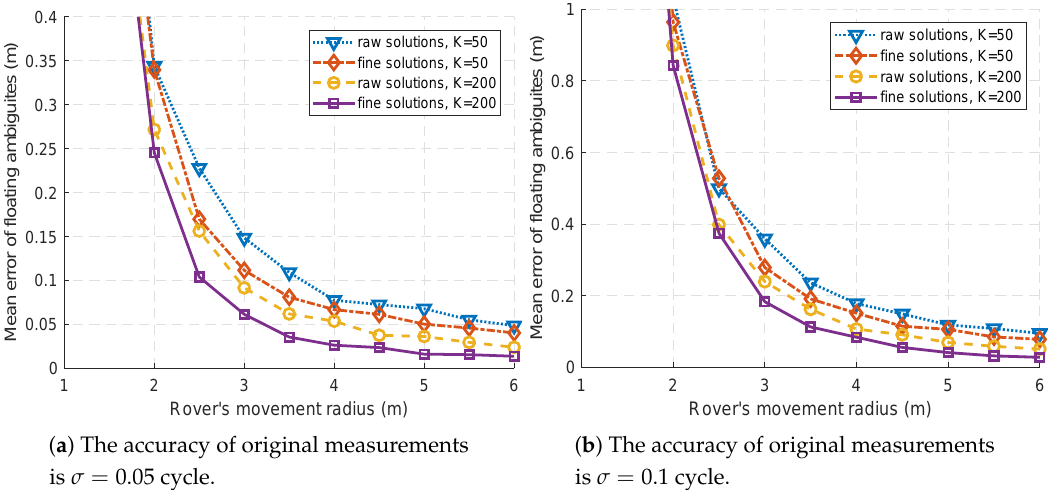
Figure 3. The comparison of mean errors between the raw and fine floating point solutions. The rover’s movement radius R is increased from 1 m to 6 m, and the results with R < 2 m are rather bad and not conducive to